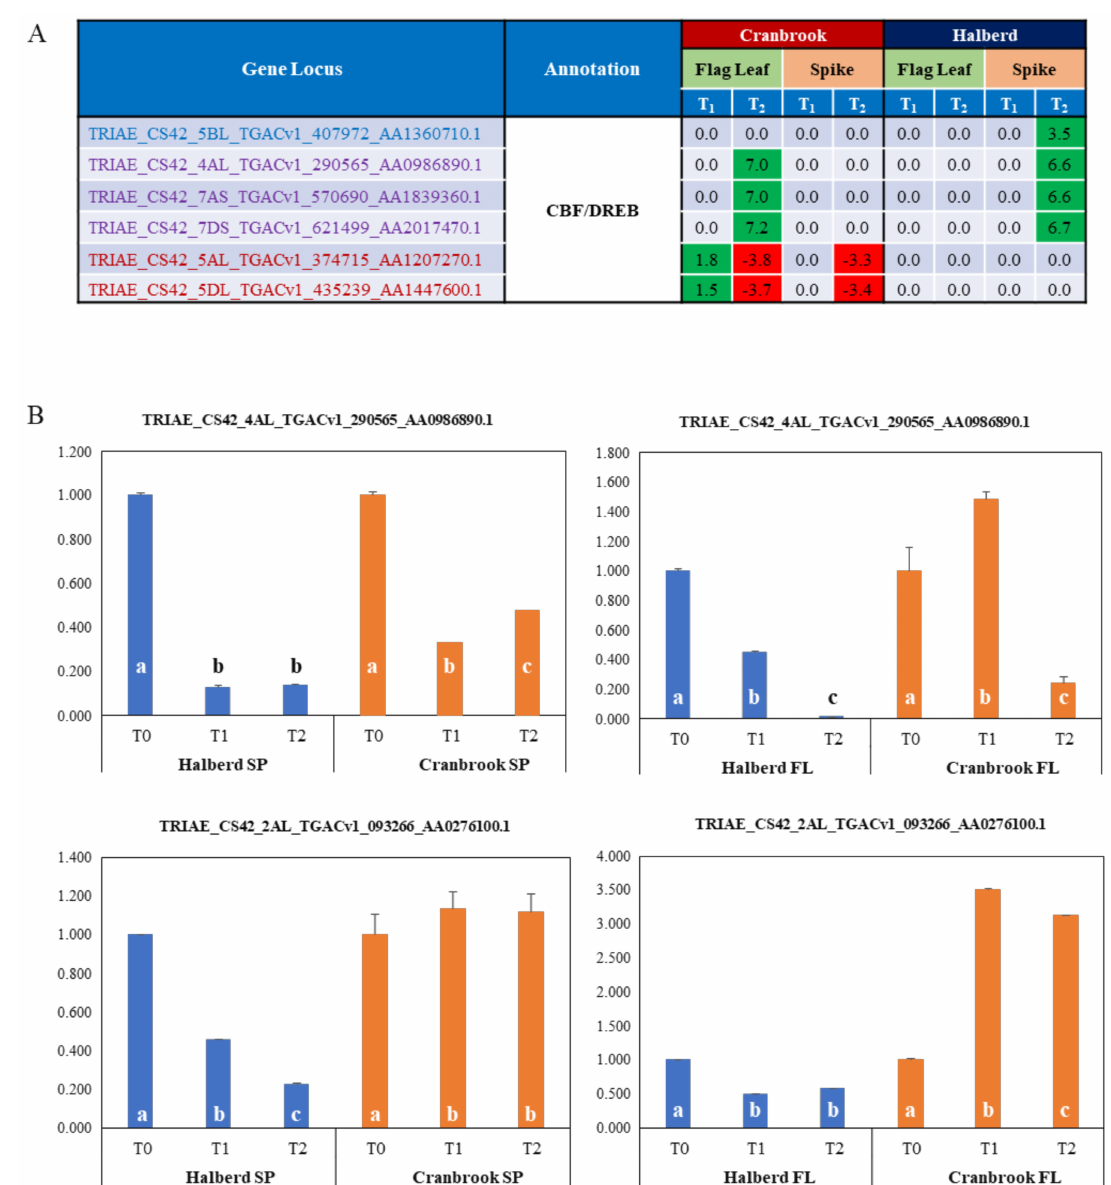
Figure 5. ( A ) List of potential CBF/DREB encoding genes that are significantly enriched in Cranbrook and Halberd flag leaves and spikes, and their LogFC expression values relative to unstressed plants (green = up-regulated; red = down- regulated). Gene loci in blue and red are specifically enriched in Halberd and Cranbrook respectively and loci in purple are enriched in both wheat lines. ( B ) Real-time PCR gene expression analysis of two CBF/DREB genes, including one enriched gene the list in A and another non-enriched CBF/DREB gene (see Supplementary Data S8). Data are the average of three repeat samples and error bars represent standard errors. Gene expression levels are relative to the unstressed control (=1) for each wheat line and bars in the graph labelled with different letters are significantly different ( t -test; p <